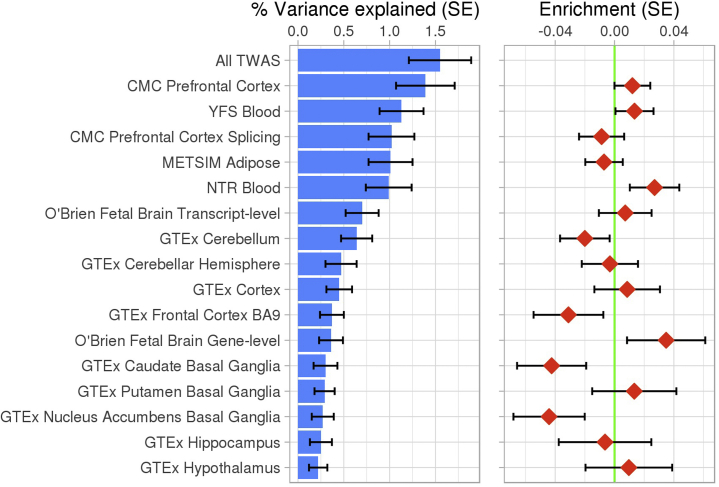
The left panel shows the autism spectrum disorder (ASD) single nucleotide polymorphism (SNP) heritability explained by predicted gene expression on a liability scale. The right panel shows results of competitive gene set enrichment analysis for SNP weight sets (i.e., whether features within each SNP weight set are on average more associated with ASD than compared with features in all other SNP weight sets). BA, Brodmann area; CMC, CommonMind Consortium; GTEx, Genotype-Tissue Expression project; METSIM, Metabolic Syndrome in Men study; NTR, Netherlands Twin Registry; TWAS, transcriptome-wide association study; YFS, Young Finns Study.